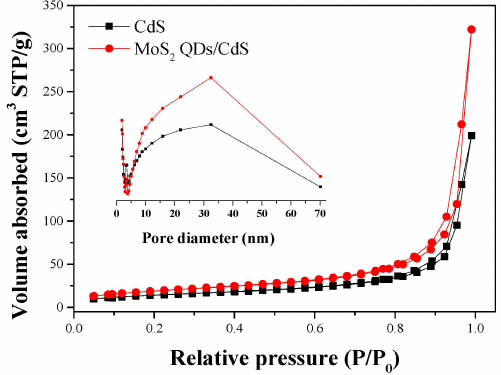
Figure 8. Nitrogen adsorption-desorption isotherms and the corresponding pore-size distribution curves (inset) for the CdS and MoS 2